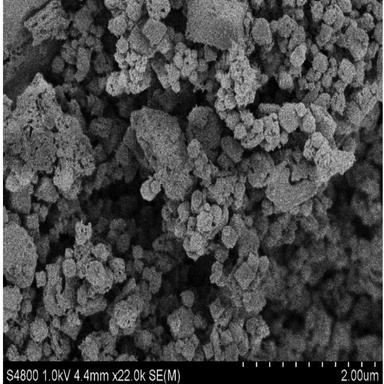
Scanning electron microscopy (SEM) of the Fe-BDC-DMF powder.